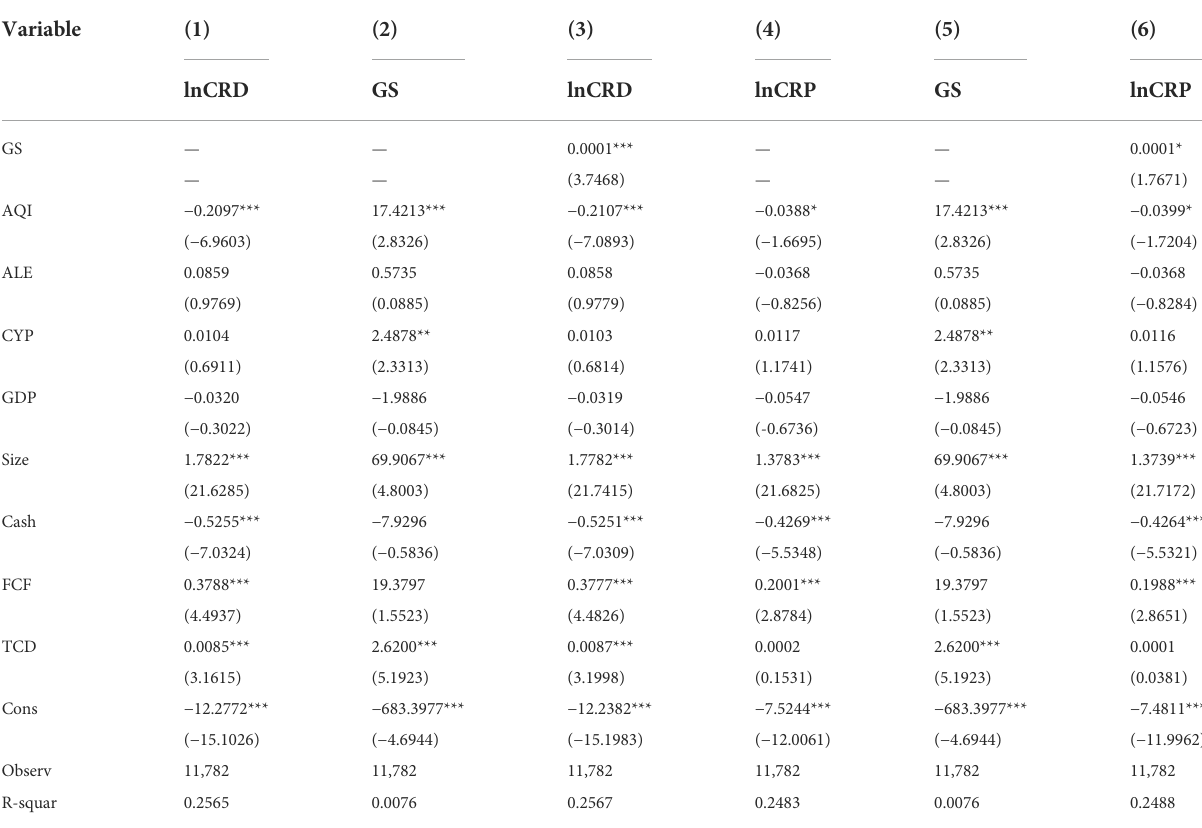
TABLE 5 Benchmark regression of the intermediary effect of government supervision. Variable